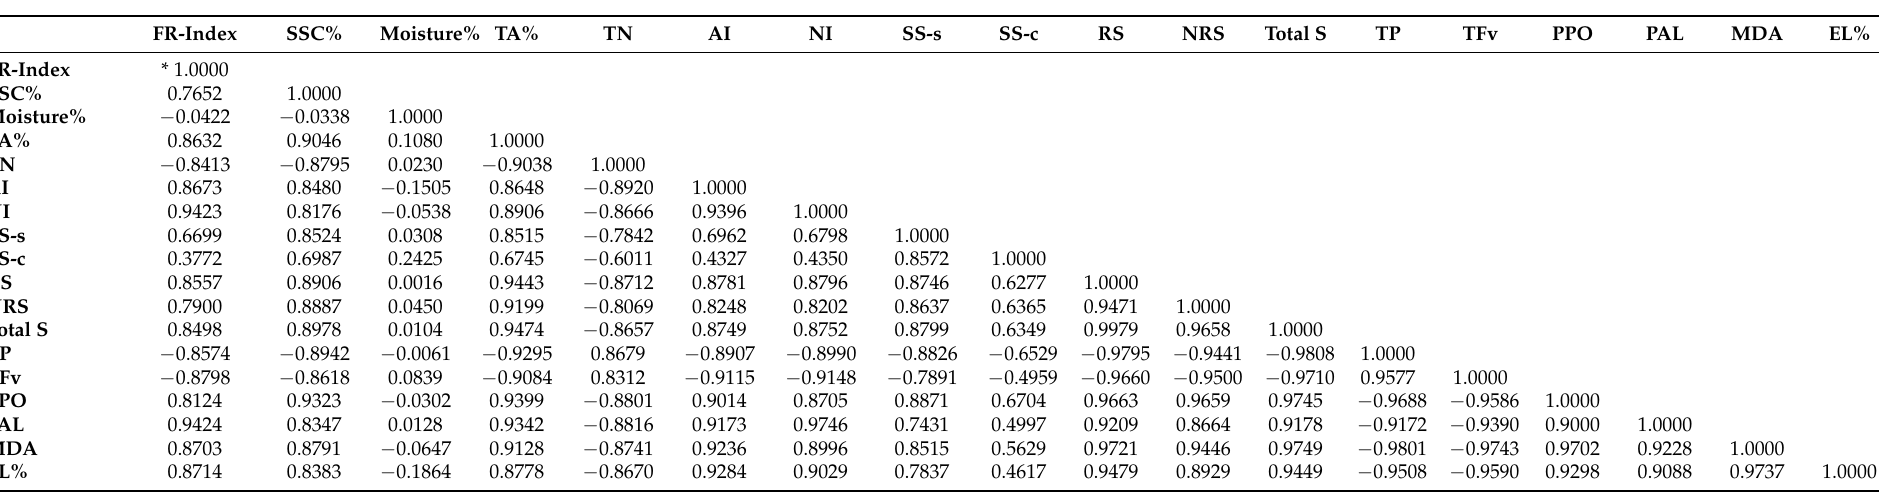
Table 1. Pearson’s correlation matrix among the studied parameters of ‘Zaghloul’ date response to ATP treatments during